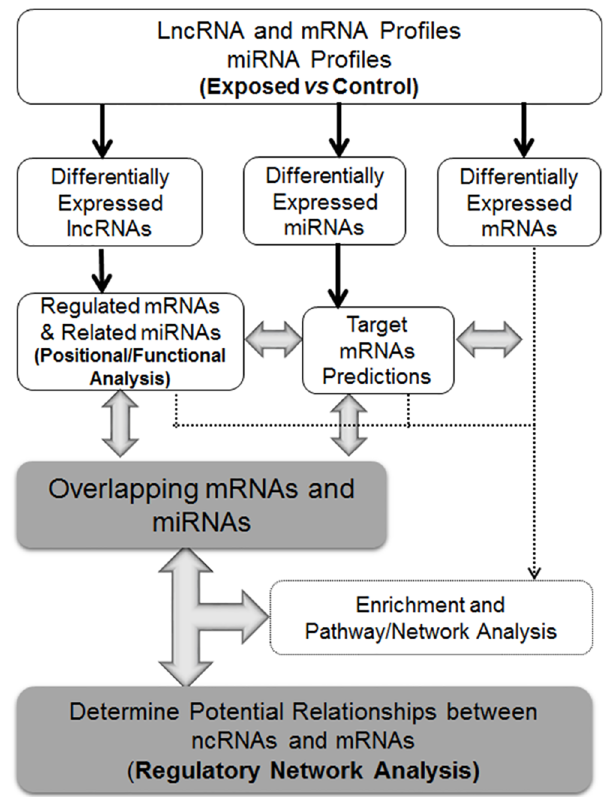
exposed and non-exposed workers.